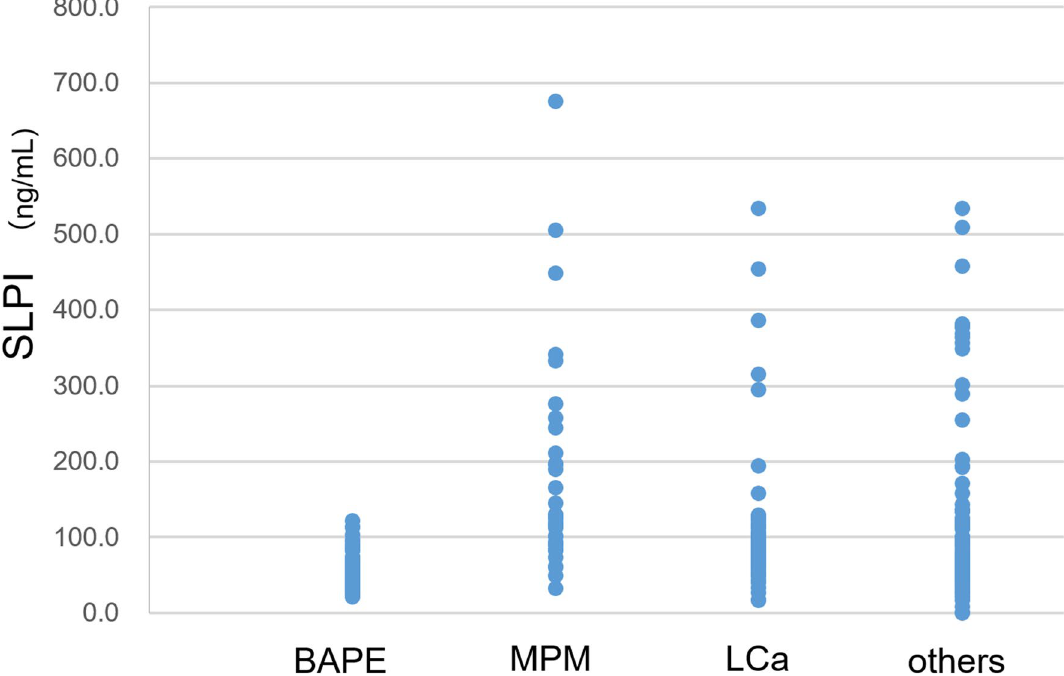
Figure 1. SLPI levels in pleural effusion from patients with BAPE, MPM, LCA, HF and IF. SLPI secretory leukocyte peptidase inhibitor, BAPE benign asbestos pleural effusion, MPM malignant pleural mesothelioma, LCA lung cancer, HF heart failure, IF bacterial pleurisy.